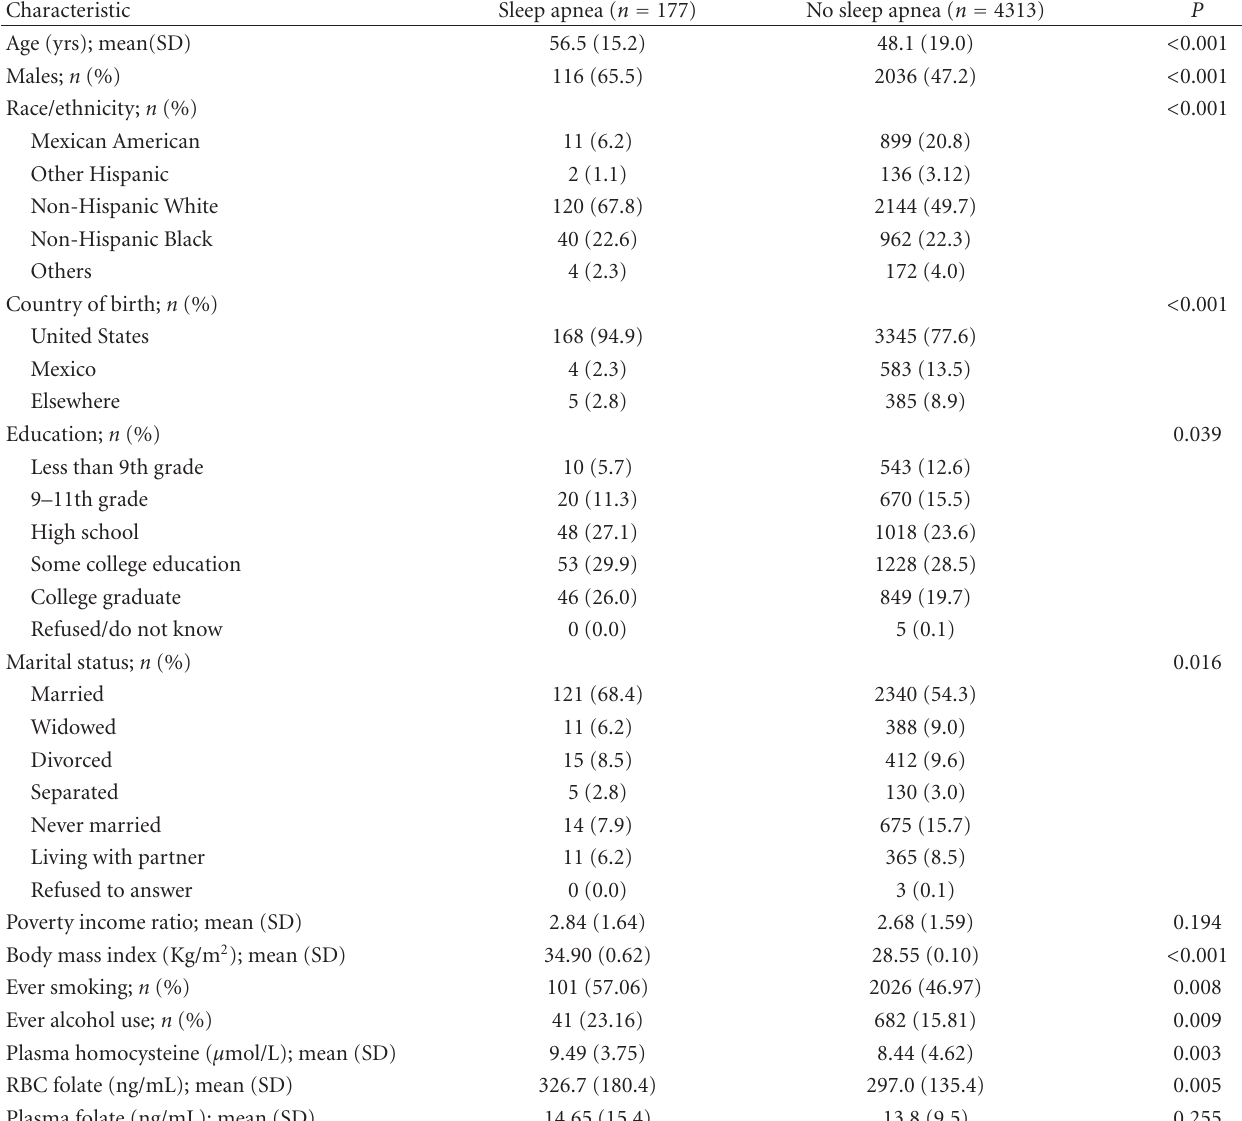
Table 2: Sociodemographic, clinical, and relevant biochemical characteristics of the population included in this study (total n = 4490).